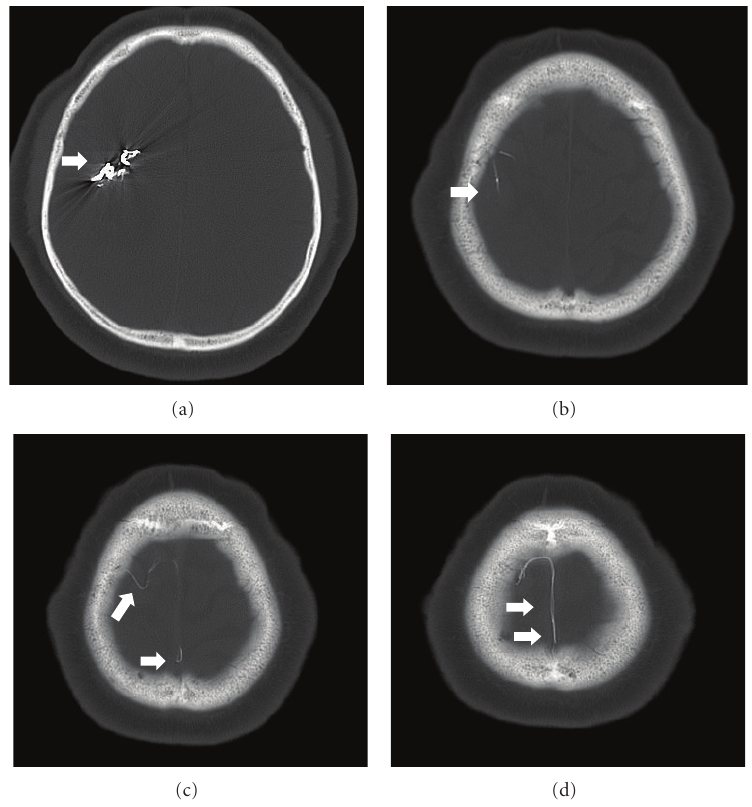
Figure 2: Bone windows of CT of the head after first embolization, showing high attenuation embolic material (Onyx) in the nidus of the AVM (a) as well as extension through the draining vein and a thin strand in the superior sagittal sinus.